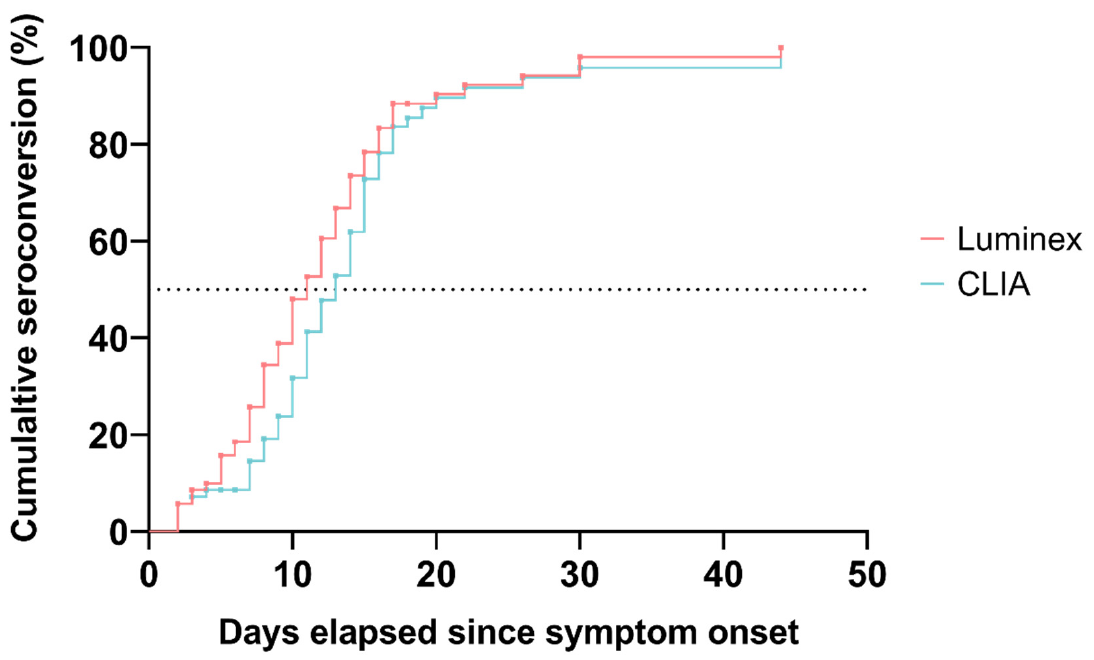
Figure 1. The cumulative proportion of patients who seroconverted according to both serological methods: Luminex (red), CLIA (blue). The dotted line represents the 50% cumulative seroconversion threshold.